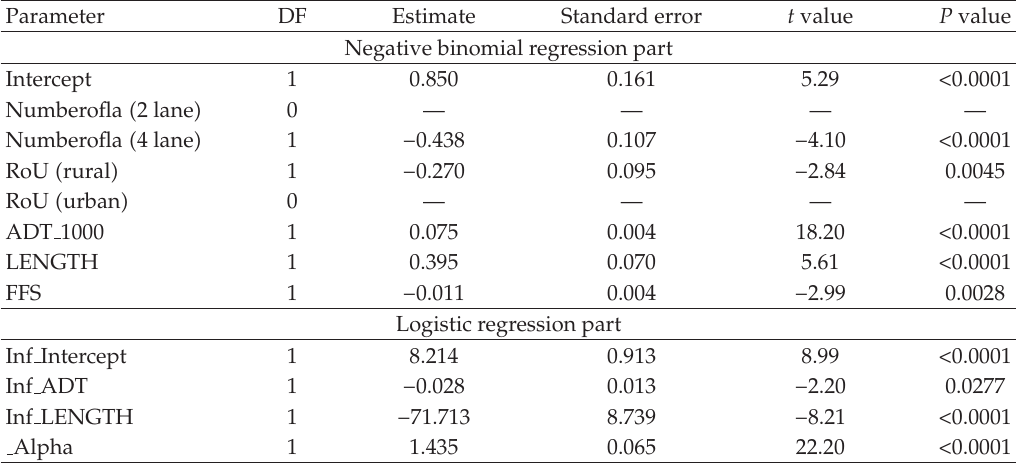
Table 4: Parameter estimates of ZINB model for total crash